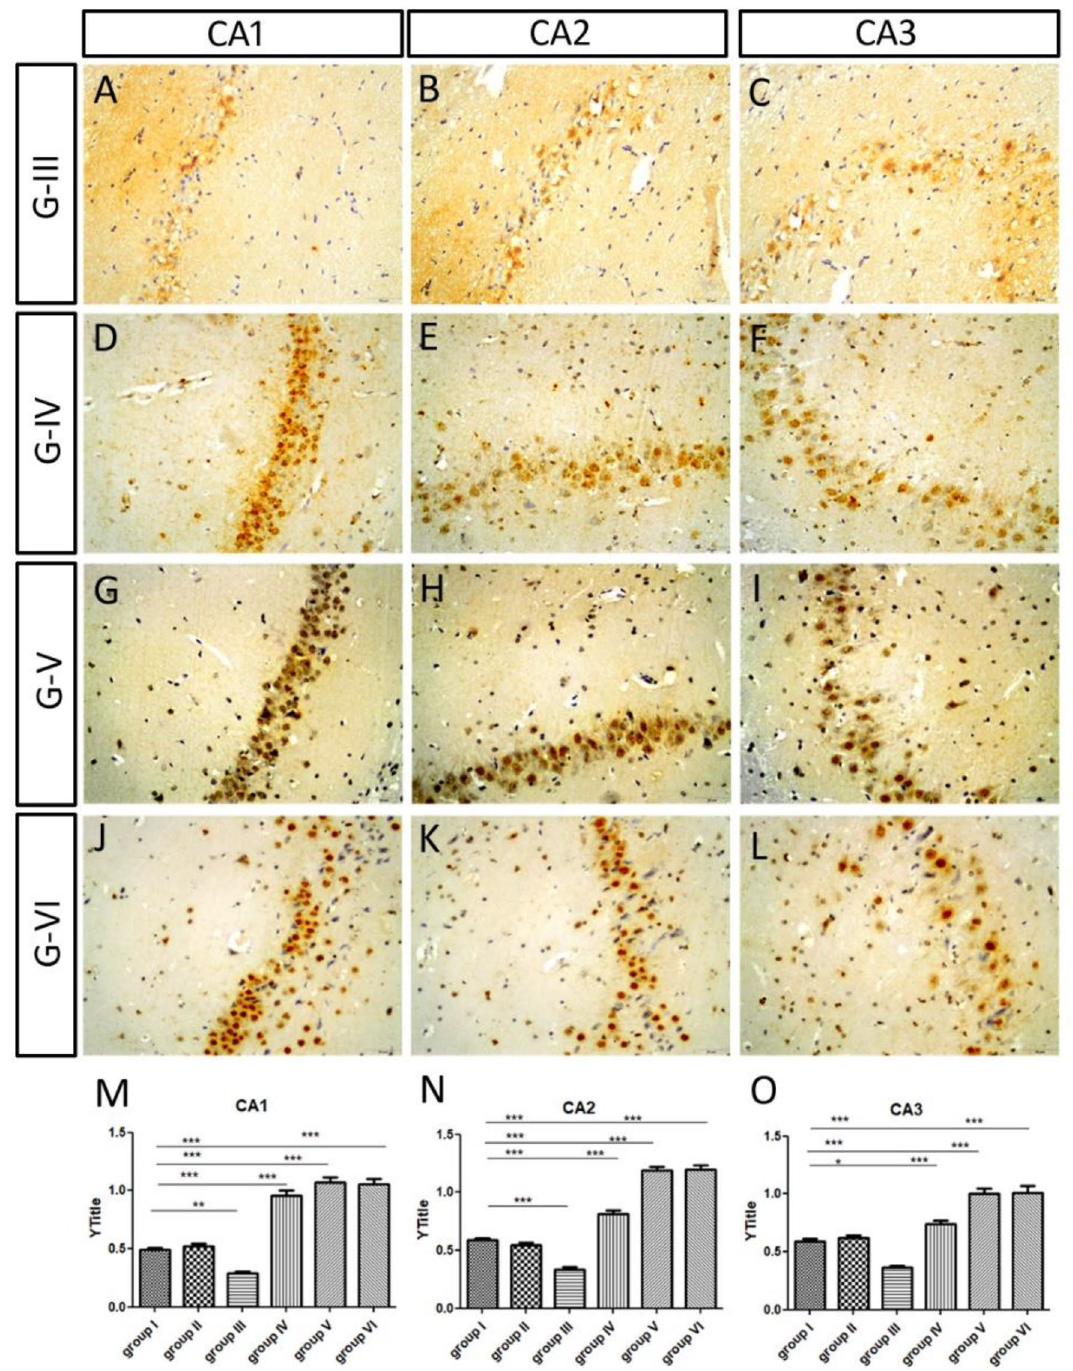
Figure 10. The expression of HCN in low and high doses of ivabradine and donepezil groups in CA: ( A – C ) The HCN1 immunoreactivity of the ES group III in CA. The HCN1 expression in CA increased in group IV, low ivabradine dose ( D – F ), increased dramatically in group V, high ivabradine dose ( G – I ). In group VI, donepezil ( J – L ), was comparable to that of the high ivabradine treated group. ( M – O ) Quantification of the optical density of HCN1 immunoreactivity in CA1 ( M ), in CA2 ( N ) and in CA3 ( O ) in different